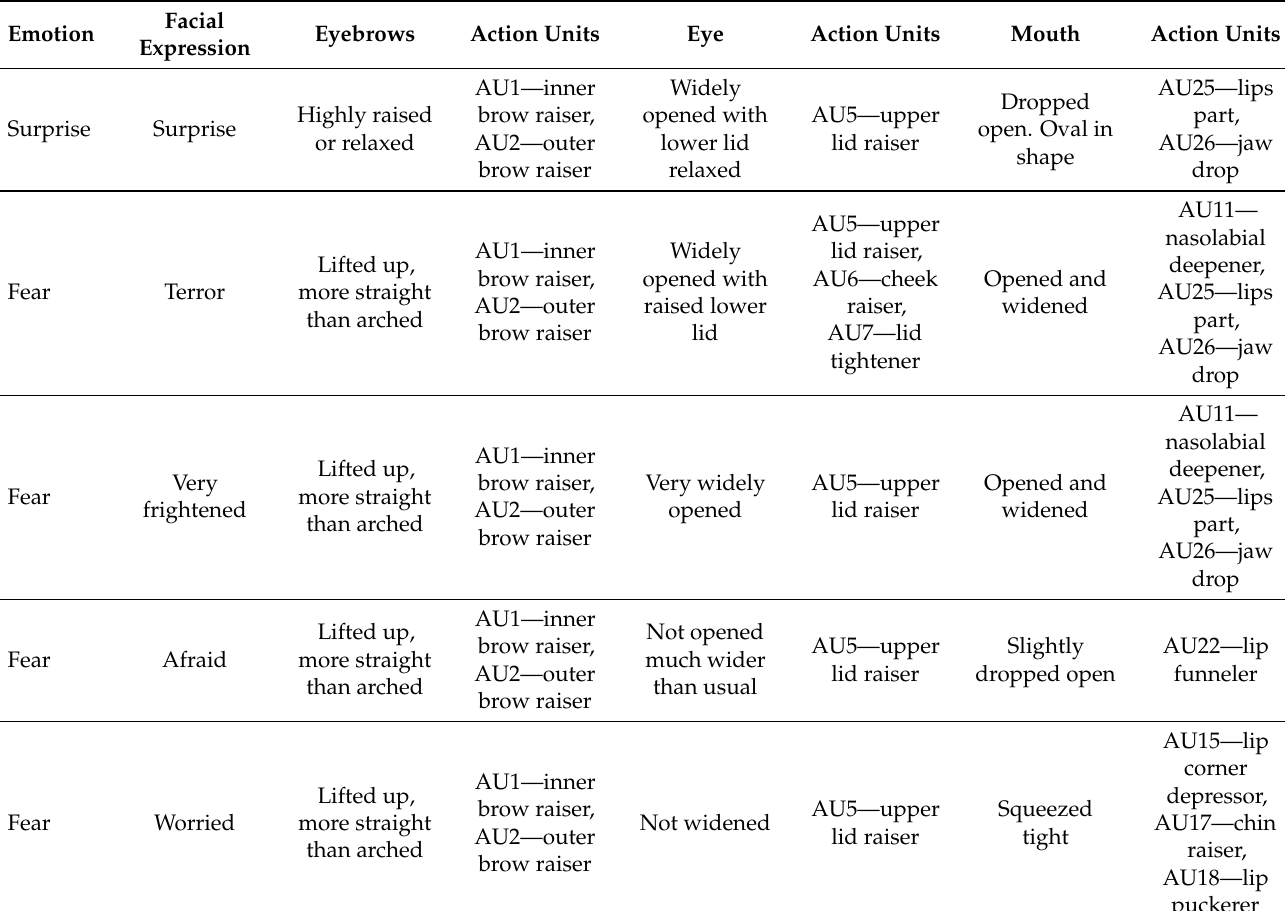
Table 4. Summary of the main facial features of the facial expressions associated with the emo- tions of suprise and fear extracted from Faigin conclusions (more detailed information can be found in Faigin [19]) and their corresponding action units